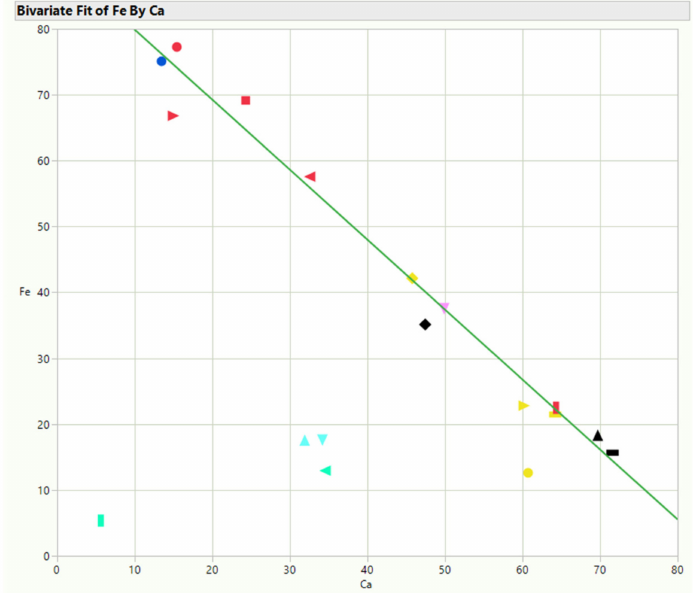
Figure 6. Fe-Ca correlation for all pigments analyzed with the pXRF technique. Symbols as in Figure